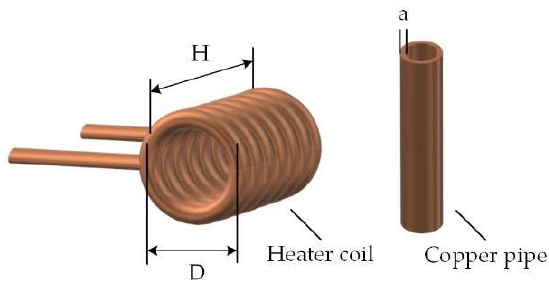
Figure 2. Schematic diagram of a round barrel helical heating coil.